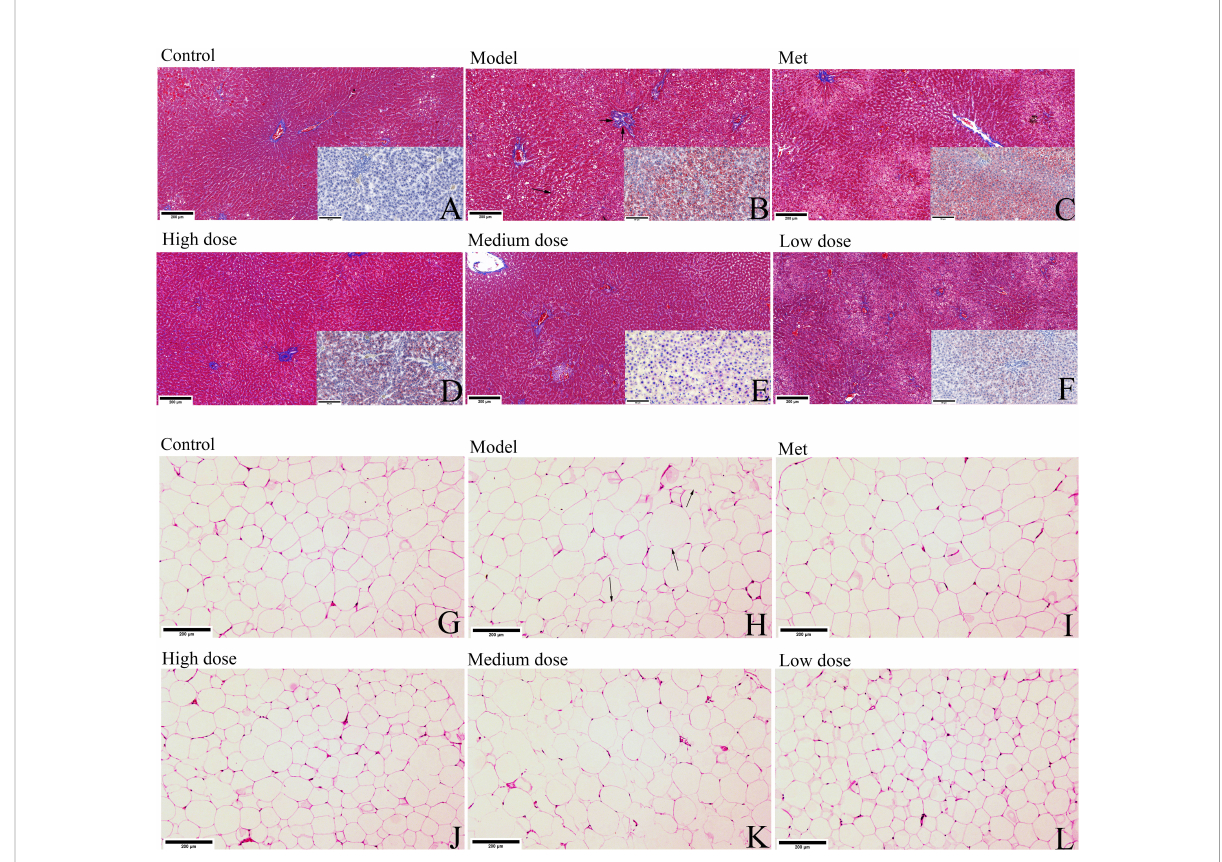
FIGURE 4 MCDD alleviates the phenomenon of PCOS-IR fatty liver and adipocyte enlargement. After the rats were sacri fi ced, the livers and small pieces of adipose tissue around ovary were collected, soaked in 4% paraformaldehyde, and stained separately with Masson trichrome and oil red O staining or hematoxylin-eosin. (A – F) The Masson trichrome-stained sections of the rat liver tissue in each group are shown in the large picture (scan bar:200 m m), and the oil red O-stained sections are shown in the small picture in the lower right corner (scan bar:50 m m). (Arrows in Masson trichrome staining show vacuolar fat vesicles, lipid deposits in hepatocytes in Oil Red O-stained sections are stained red). (G – L) HE sections of adipose tissue of rats in each group (scan bar:200 m m). (In the model group, arrows indicate fat cells with increased volume and irregular shapes). The above results, n